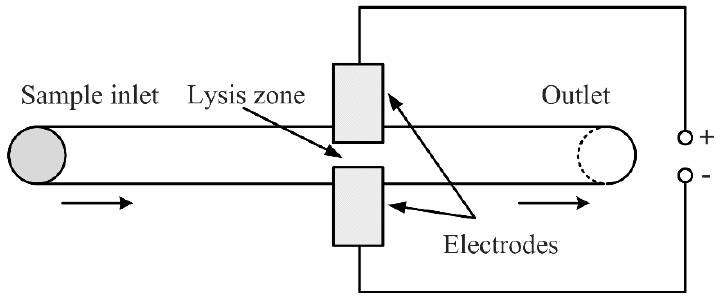
Figure 15. Schematic generalization of a microfluidic device for mechanical